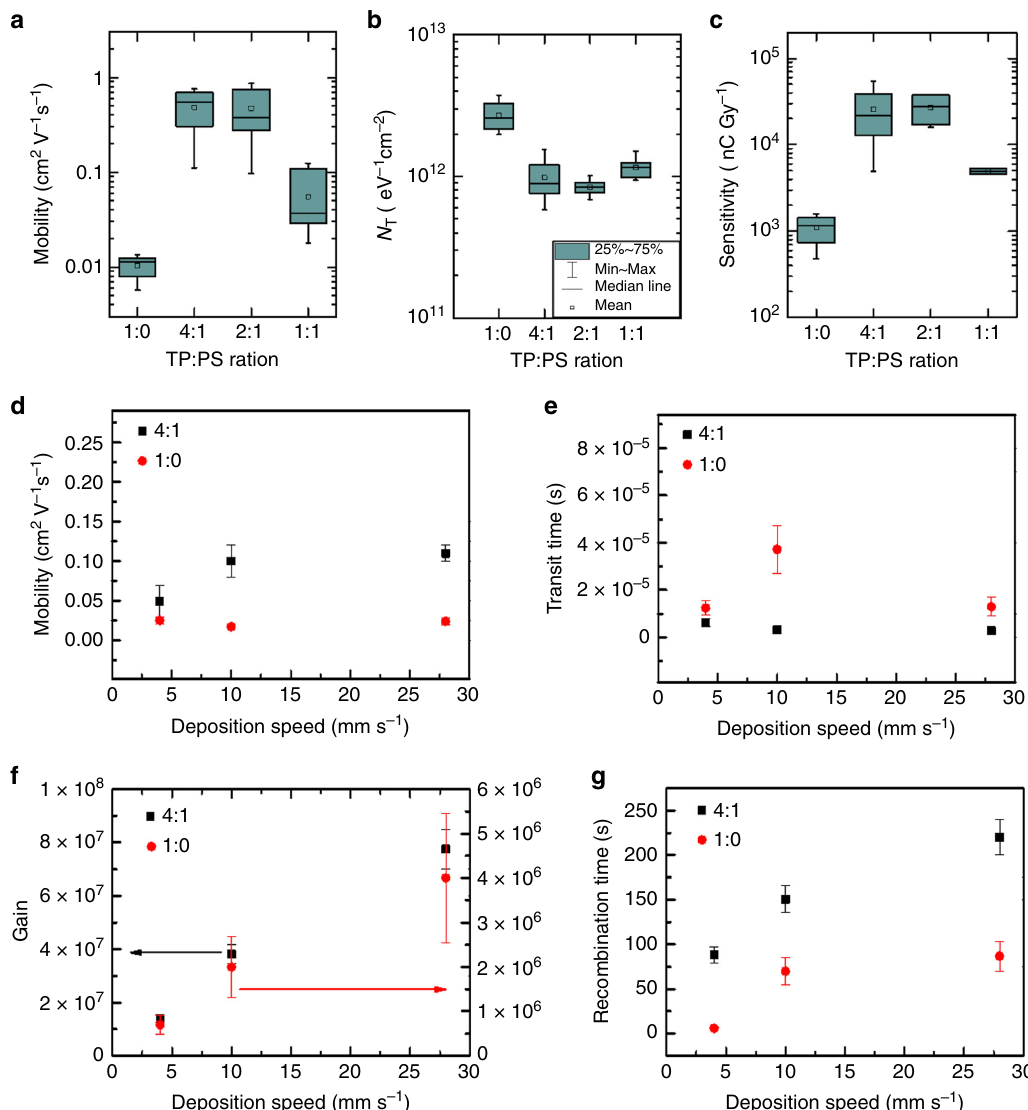
Fig. 4 Impact of OFET electrical performance on X-ray detection sensitivity. a , b Box-plot statistics for the OFET mobility and hole trap density, respectively, obtained from ten devices of each TIPS-pentacene:PS blend ratio (1:0, 4:1, 2:1, and 1:1). c Device X-ray sensitivity of 1:0, 4:1, 2:1, and 1:1 TIPS- pentacene: PS devices. The error bars refer to the statistical fl uctuations of the parameters over ten samples for each blend ratio. Comparison between pure TIPS-pentacene (1:0) and blended (4:1) devices of: d experimentally determined mobility and e corresponding transit time; analytically determined f photoconductive gain and g recombination time, for different deposition speeds. The error bars refer to the statistical fl uctuations of the parameters over four samples for each deposition